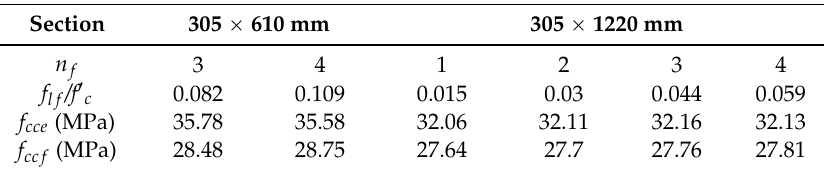
Table 15. Extracted analysis